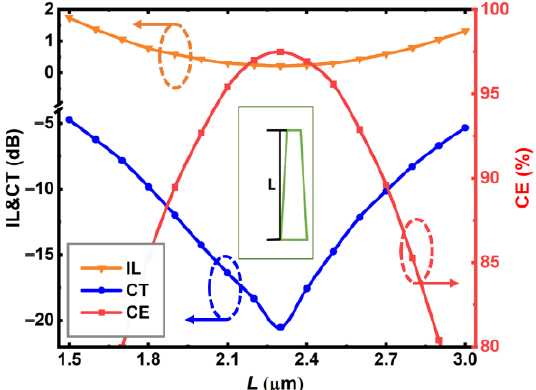
Figure 3. Calculated mode CE, CT, and IL of the proposed mode converter as a function of the PCM (Sb 2 Se 3 ) taper length L . The embedded Sb 2 Se 3 layer works at the crystalline state and the inset shows the calculated taper length.